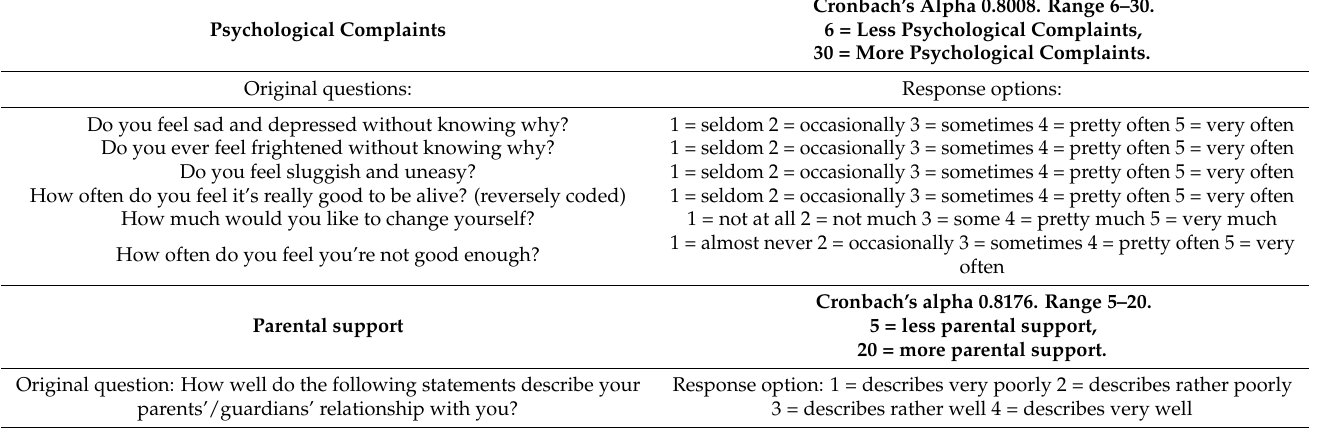
Table 1. Items included in the dependent, independent, and mediating